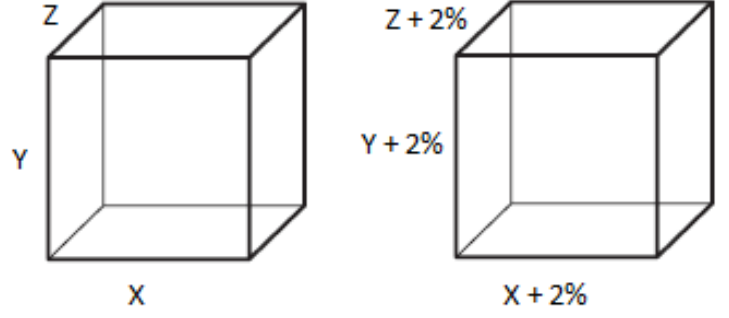
Figure 13. Original model ( left ). Corrected model ( right ).